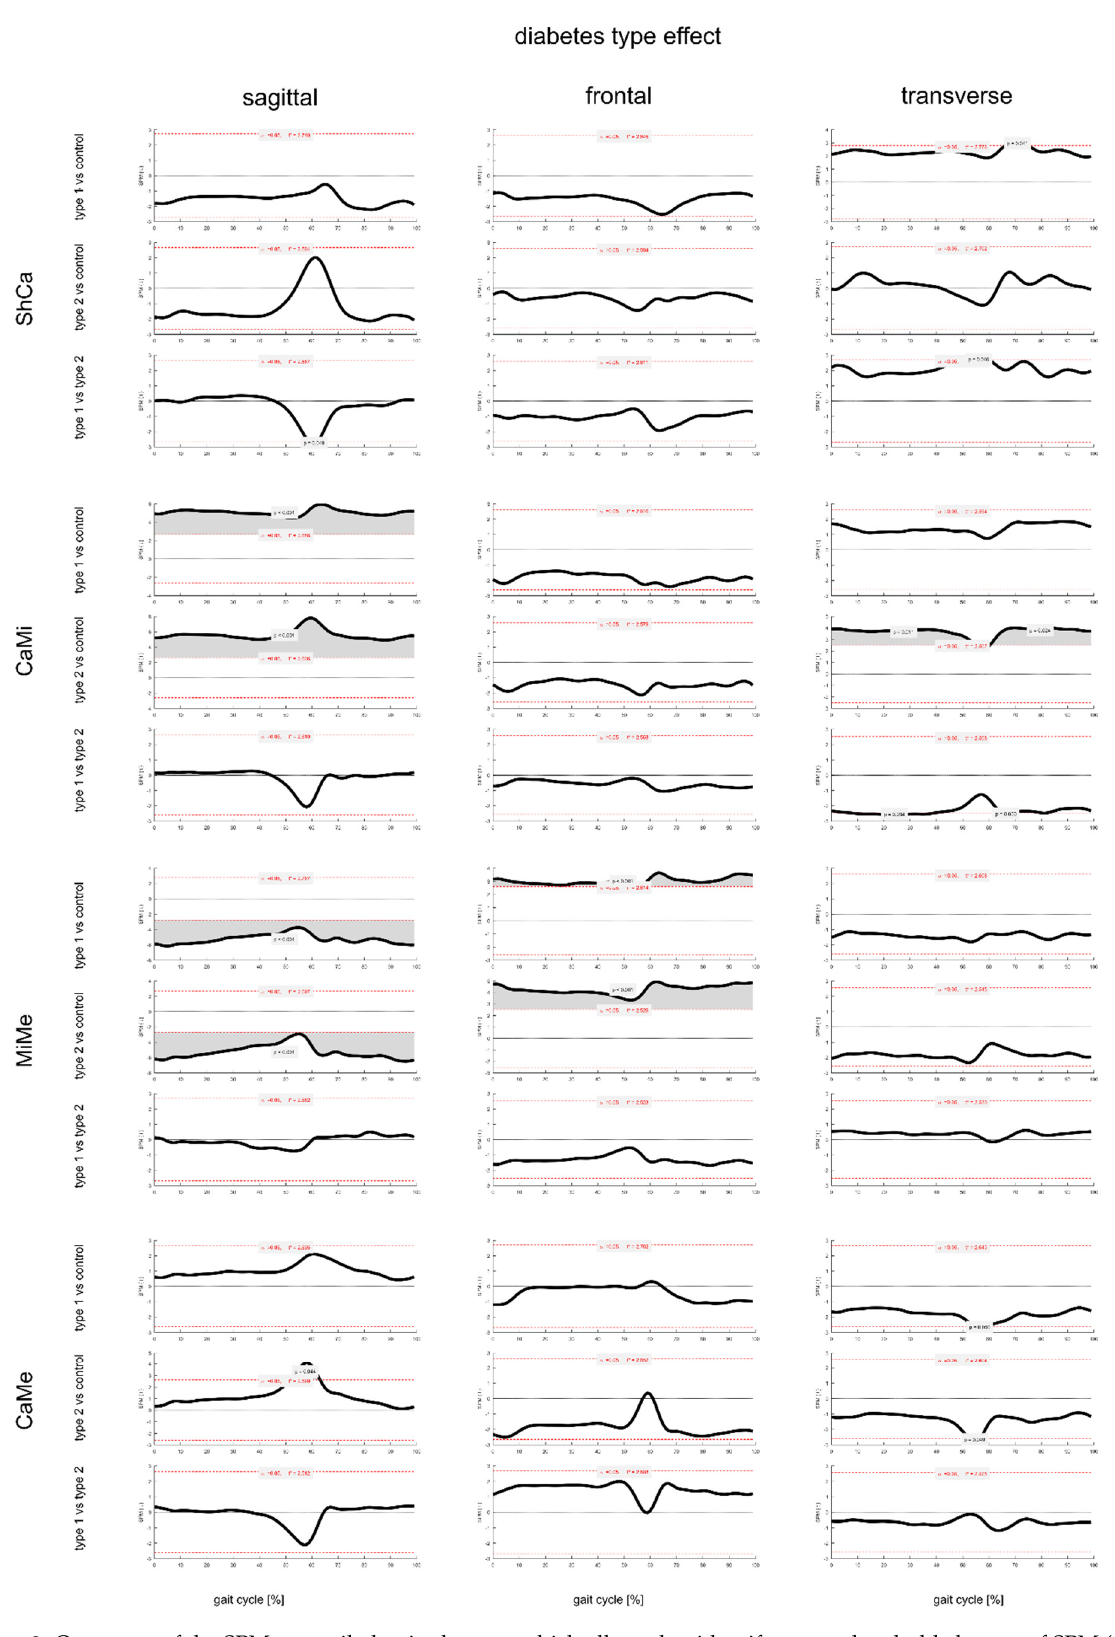
Figure 3. Outcomes of the SPM two-tailed paired t-tests which allowed to identify supra-threshold clusters of SPM (t) for the pairwise comparisons between temporal profiles of joint rotations in type 1, type 2 and control groups. Time intervals of statistically significant differences ( p < 0.05) between groups are shown in grey.